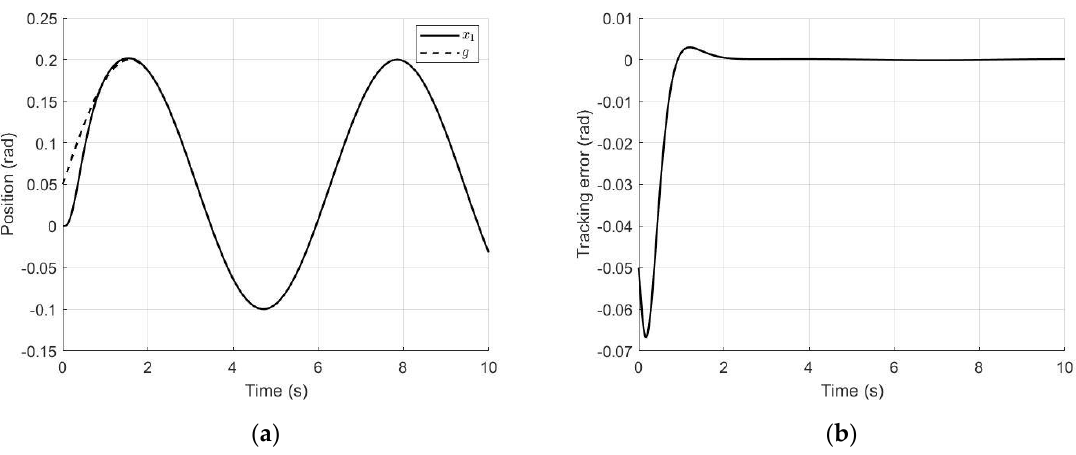
Figure 11. Experiment 3. In ( a ), plots of the reference signal g ( t ) and the output x 1 ( t ) ; in ( b ), plot of the tracking error e 1 = x 1 ( t ) − g ( t ) .